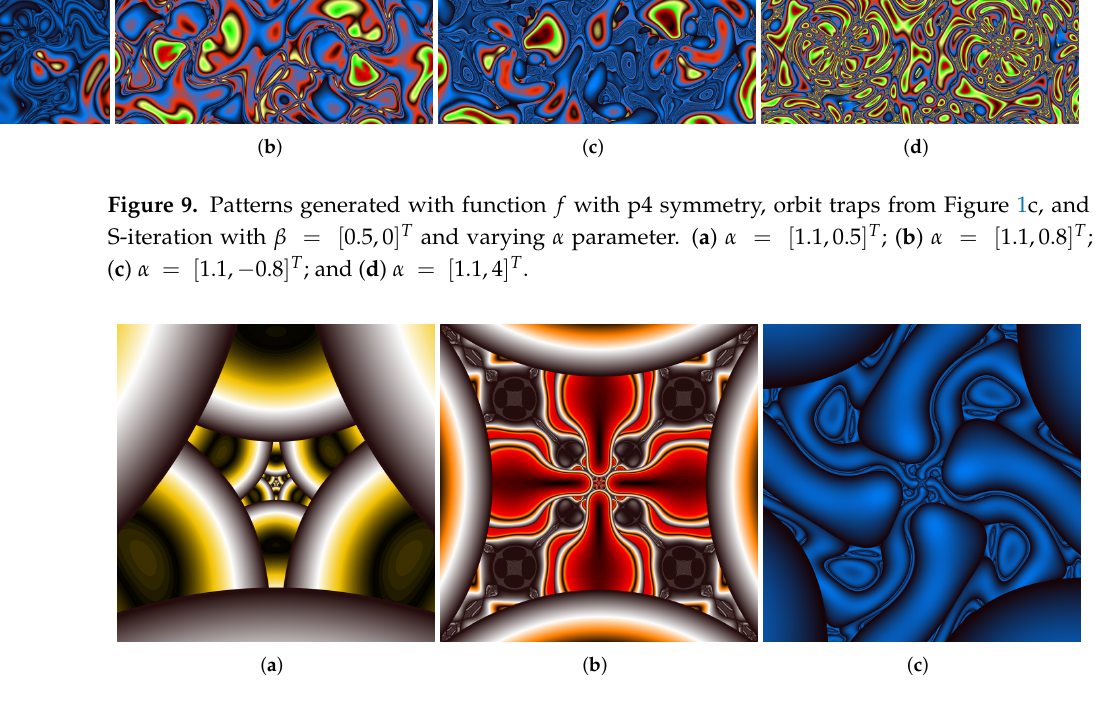
Figure 10. Magnifications of the areas near the origin of patterns from Figures 5c, 8c and 9a. These magnifications show the local self-similarity property of the patterns. ( a ) Figure 5c; ( b ) Figure 8c; and ( c ) Figure